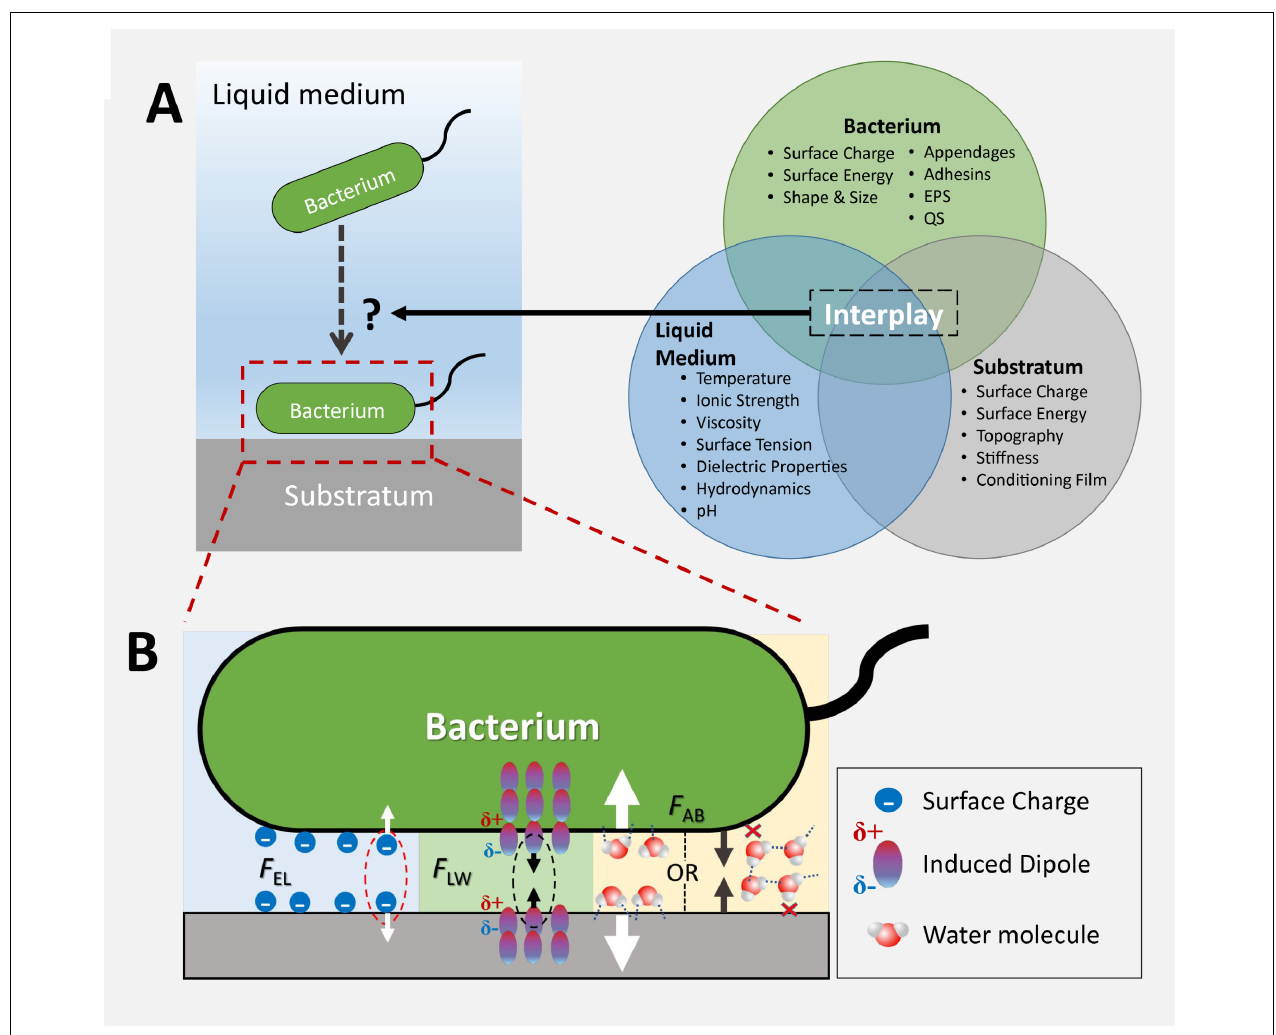
FIGURE 1 | A schematic representation of the factors that influence initial bacterial attachment to a solid-liquid interface. (A) The outcome of the attachment process is governed by the interplay between the properties of the bacterium, solid surface, and the liquid medium; (B) Physicochemical forces and other factors that affect attachment. EPS, extracellular polymeric substances; QS, quorum sensing; EL, electrostatic interaction; LW, Lifshitz-van der Waals interaction; AB, acid-base interaction. Figure adapted from Cheng and Moraru (2018), with